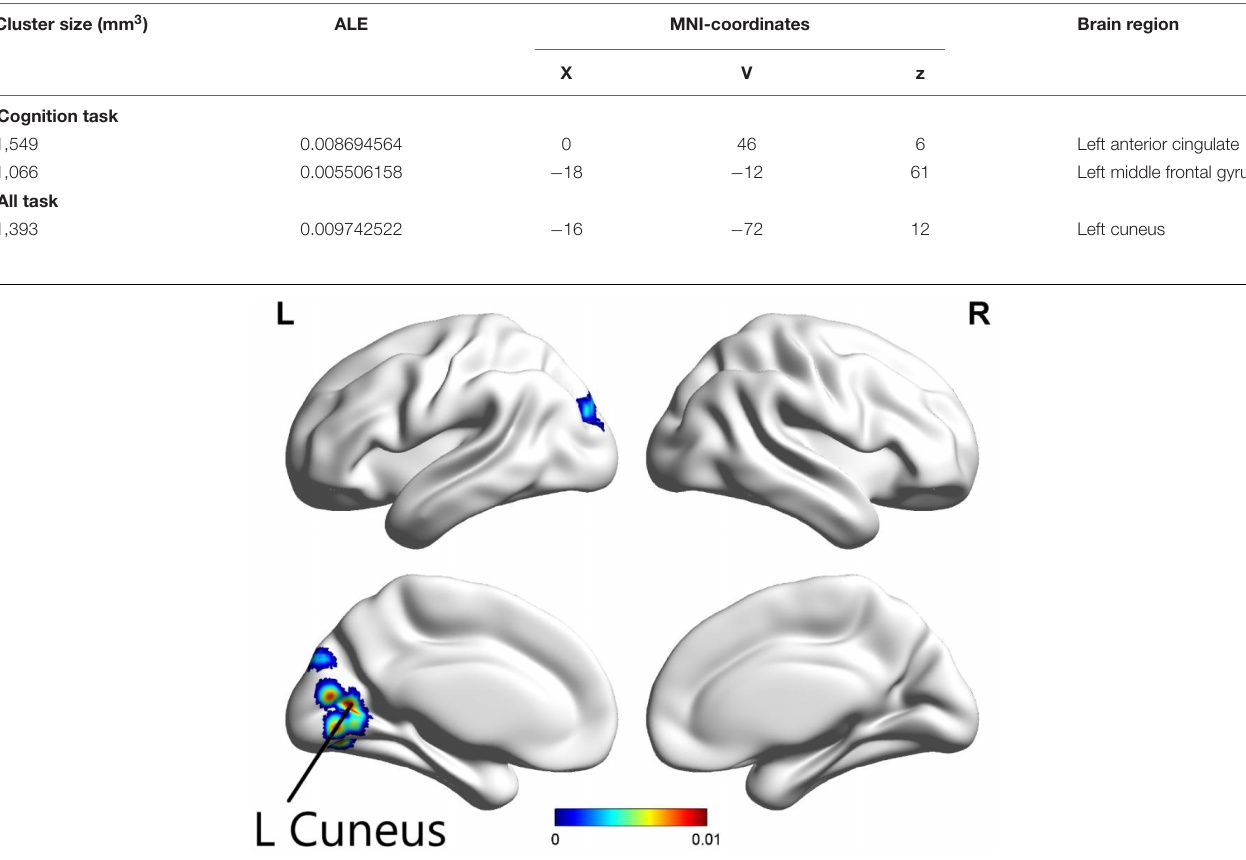
TABLE 2 | Activation areas resulting from meta-analysis, peak voxels, ALE values, and cluster sizes are included. Cluster size (mm 3